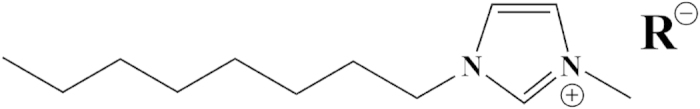
The structure of the ILs used in the present study.The letter R represents the anion (i.e., Cl, Br or BF4).